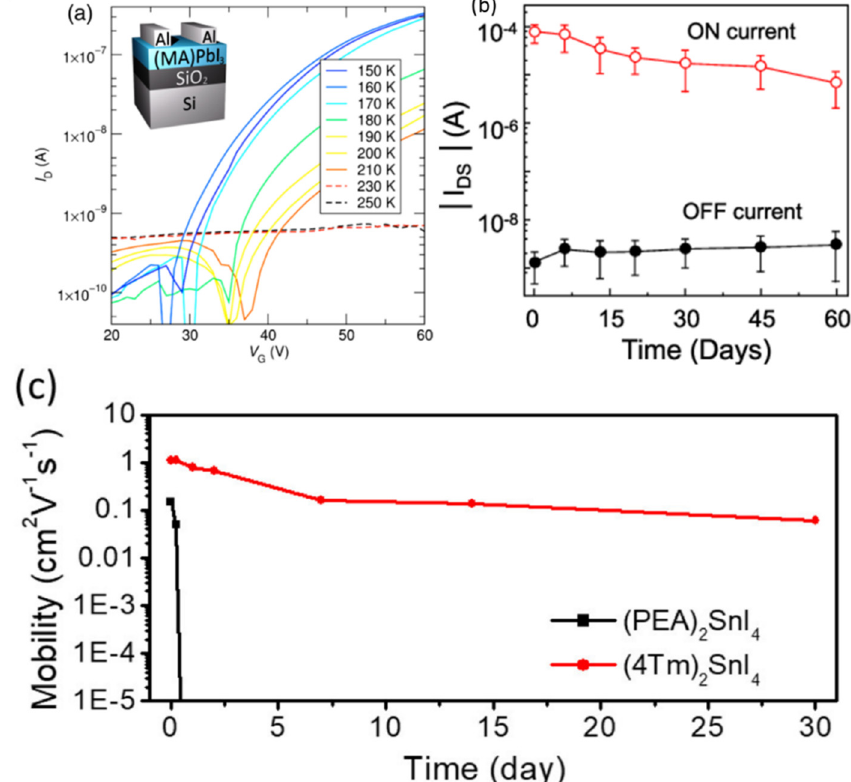
Figure 13. ( a ) Transfer curves of MAPbI 3 -based FET at various temperatures between 150K and 250K [94]. ( b ) Evolution of ON and OFF currents as a function of time, where the devices were kept in the dark with a relative humidity between 40% and 60% over a period of 2 months in ambient atmosphere. Reproduced with permission from [196]. Copyright 2020, American Chemical Society. ( c ) Evolution of hole mobilities of the BGTC FET devices based on (PEA) 2 SnI 4 and (4Tm) 2 SnI 4 over a long storage time. Reproduced with the permission from [157]. Copyright 2019, American Chemical Society.